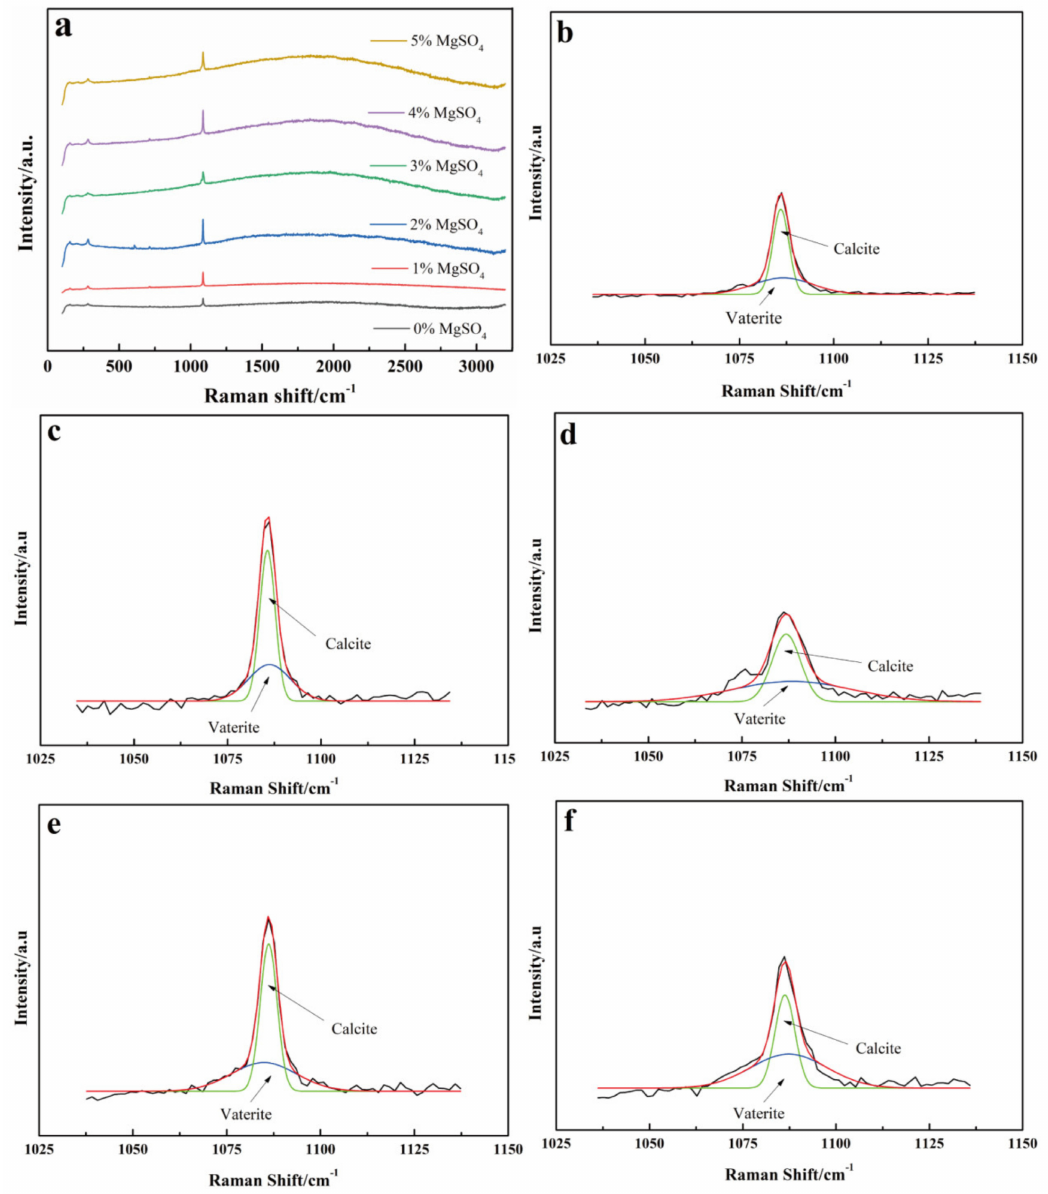
Figure 6. A full spectrum and thorough analysis of magnetized anti-scaling products with di ff erent magnesium sulfate dosage: ( a ) full spectrum; ( b ) 1%; ( c ) 2%; ( d ) 3%; ( e ) 4%; ( f )